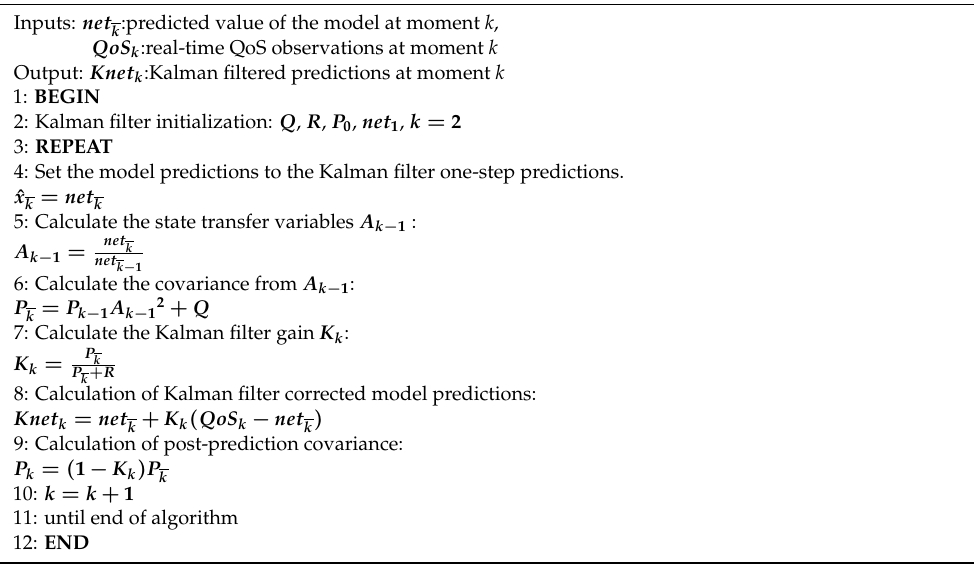
Algorithm 2: Kalman filter-based deep learning predictive value correction algorithm.